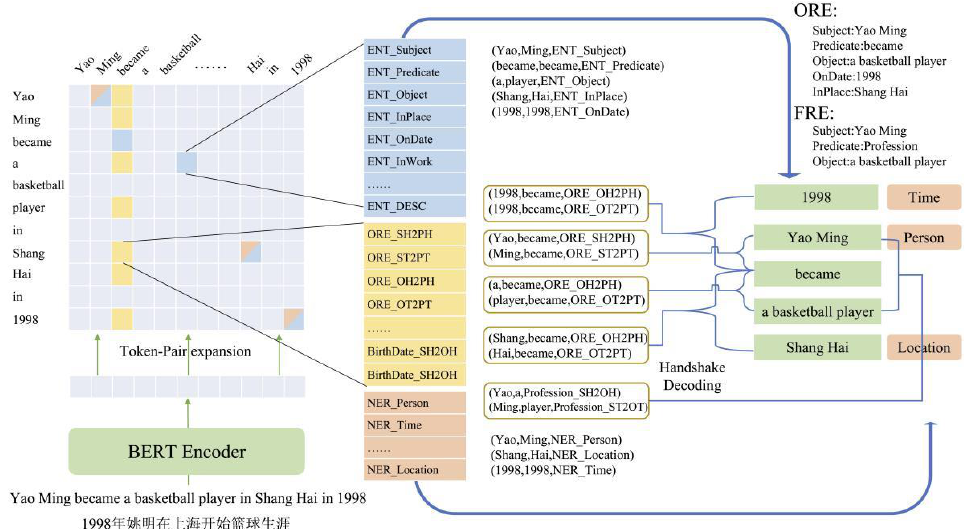
Figure 1. The overall structure of the model. To make it easier to understand, the FFN of ORE and the FFN of NER are drawn separately in the figure, but they actually share the same FFN. In order to make each character in Chinese and English correspond, here we translated ”Shanghai” to “Shang Hai ”.